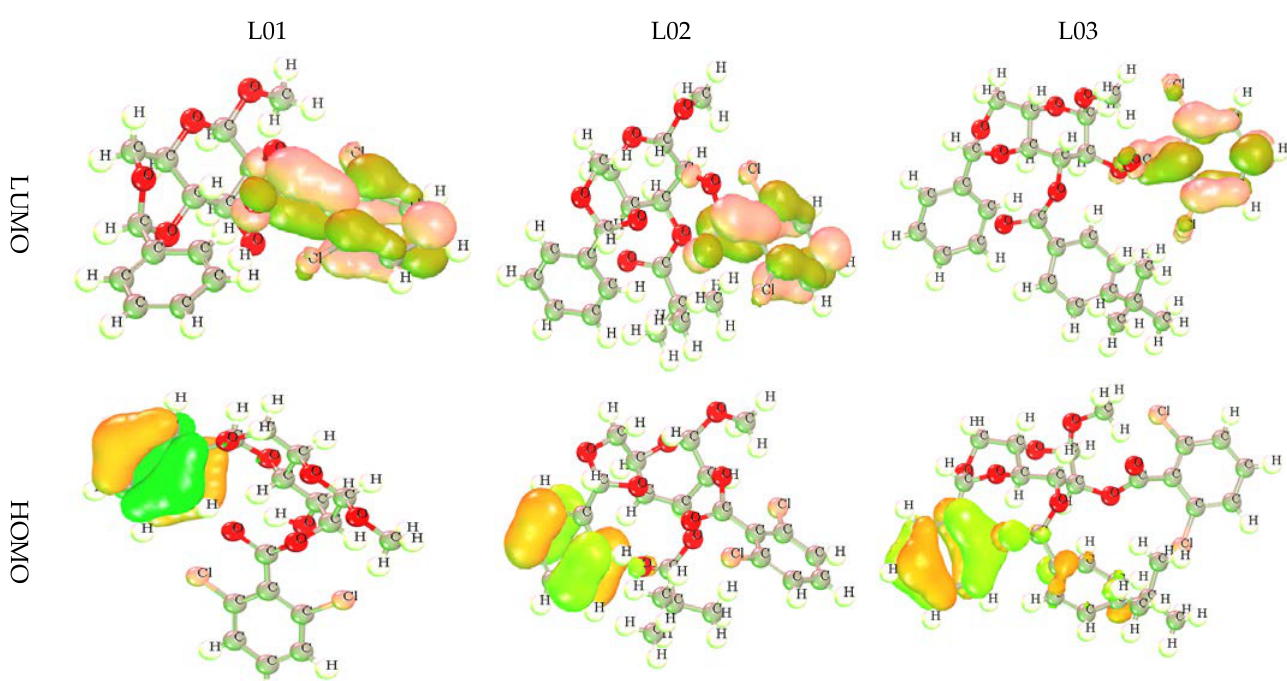
Figure 2. Frontier molecular orbitals diagram for HOMO and LUMO.